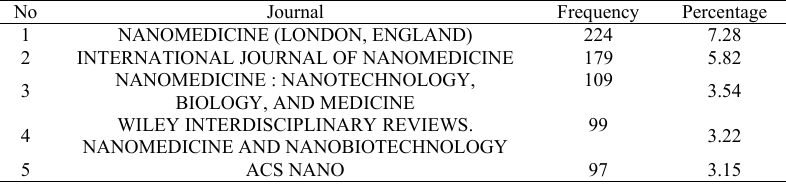
Table 2. The top 5 Source title of nanomedicine papers